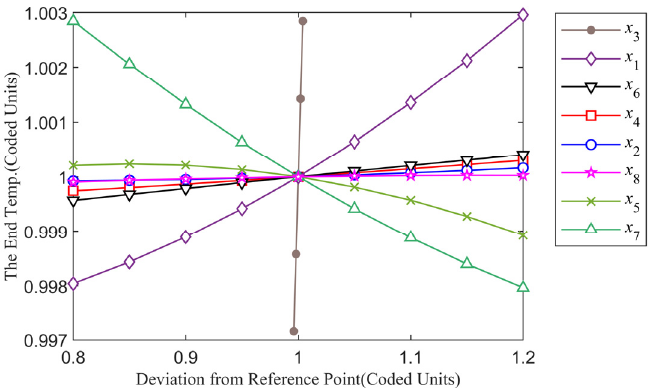
Figure 8. The perturbation plot illustrating the influence of single independent variables on the end temperature.